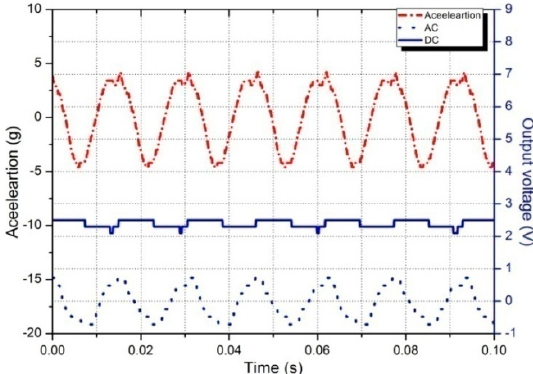
Figure 21. AC output from the harvester and DC output from the voltage quadruple rectifier circuit.